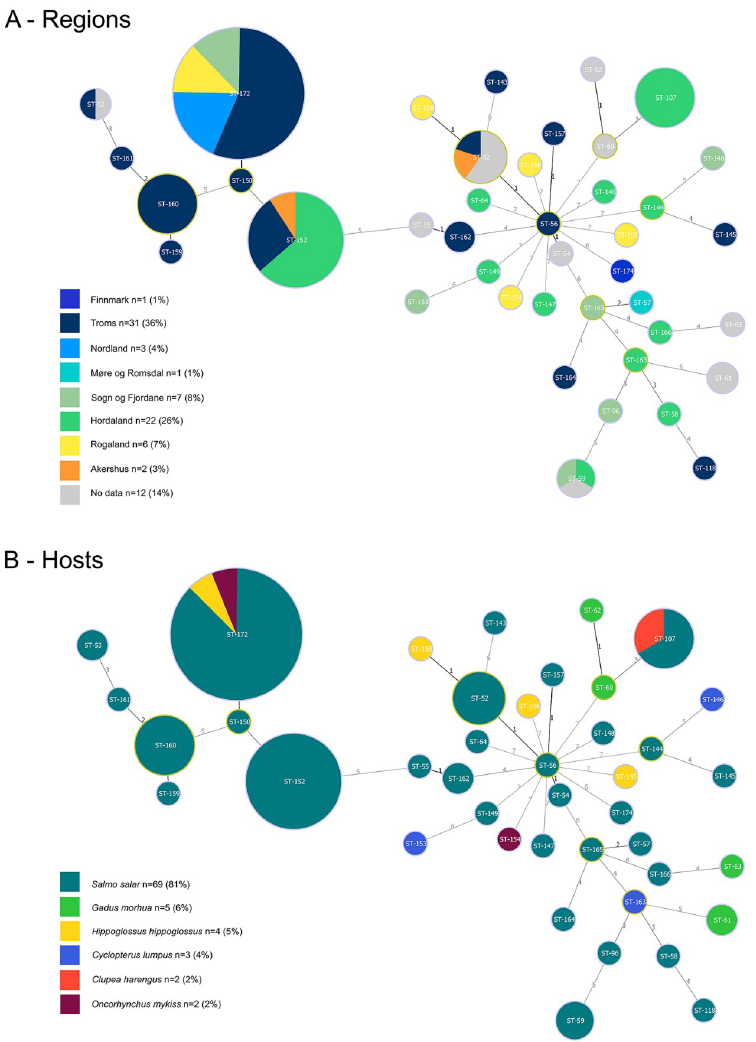
Fig 1. Minimum spanning tree. Minimum spanning tree of Tenacibaculum strains based on 7 loci ( atpA , dnaK , glyA , gyrB , infB , rlmN and tgt ) using the goeBURST Full MLST algorithm. The sequence types (STs) are identified by a number (ST-, see https://pubmlst.org/tenacibaculum/). The circle size reflects their abundance in the data set. Group founders are indicated by a yellow circle. The analysis includes 67 new isolates for the database (66 STs from this study and ST-174 assigned to HFJ strain), and 18 STs already published. The DNA relatedness is presented with emphasis on regions (A) or hosts